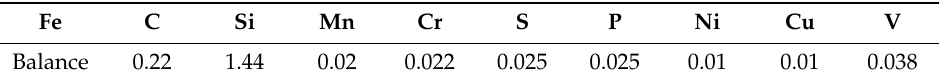
Table 1. Chemical composition of 20 MnSiV carbon-steel rebar (mass fraction %).